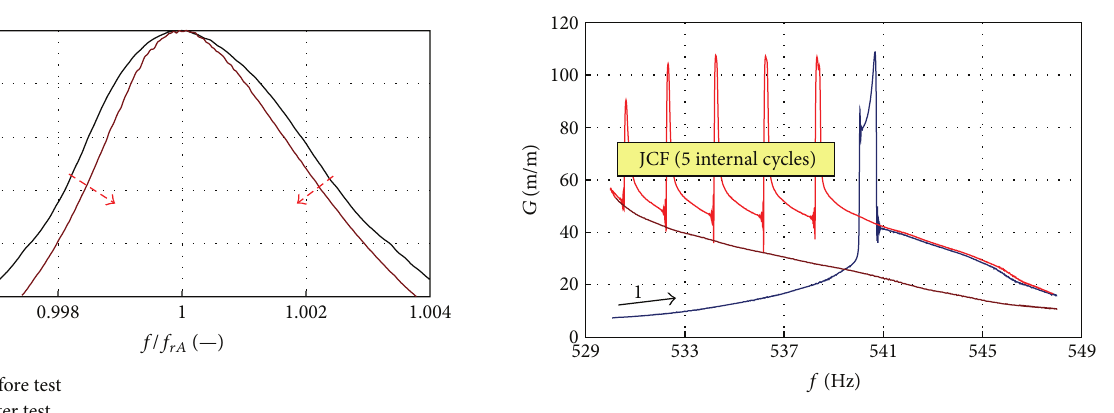
Figure 31: The JCF phenomenon for a cracking blade with Ti5.8Al- 3.7Mo (sine sweep 4Hz/min with constant external load) [3, 23].